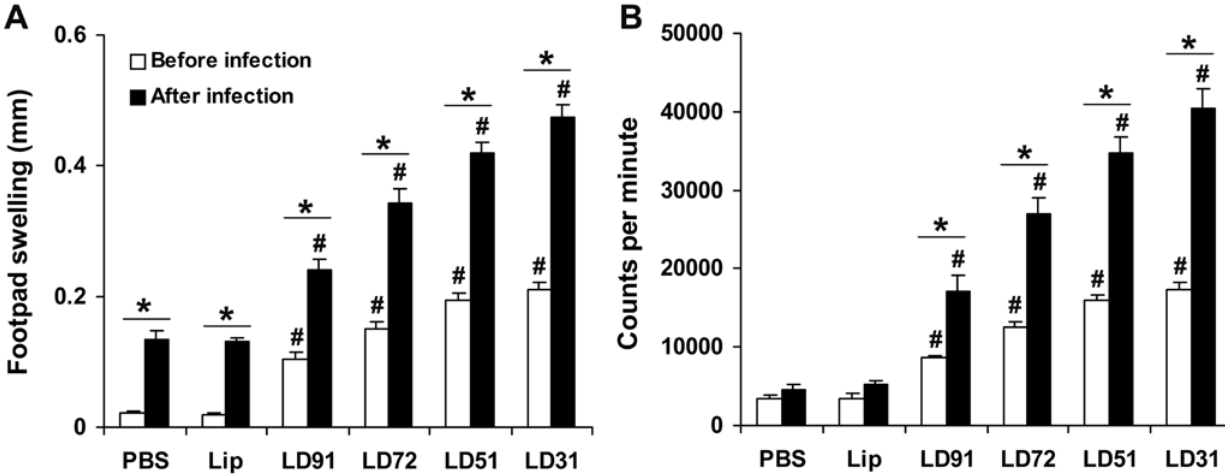
Figure 3. DTH and splenocyte proliferation in BALB/c mice vaccinated with cationic liposomal antigens before and after challenge infection. Ten days after the last vaccination and 3 months after challenge infection DTH (A) and splenocyte proliferative (B) responses were measured. DTH response is expressed as the difference (in millimeters) between the thickness of the test (LAg-injected) and control (PBS-injected) footpads at 24 h. Spleens were collected and splenocytes were restimulated in vitro for 72 h with 2.5 m g/ml of specific antigens. Antigen-specific splenocyte proliferation was determined by thymidine incorporation and expressed as counts per minute. Each sample was examined in triplicate. The results are shown as the mean 6 S.E. for five individual mice per group, representative of two independent experiments with similar results. # p , 0.0001 in comparison to control groups and * p , 0.001 in comparison to data before infection as assessed by two-way ANOVA and Bonferroni’s correction.